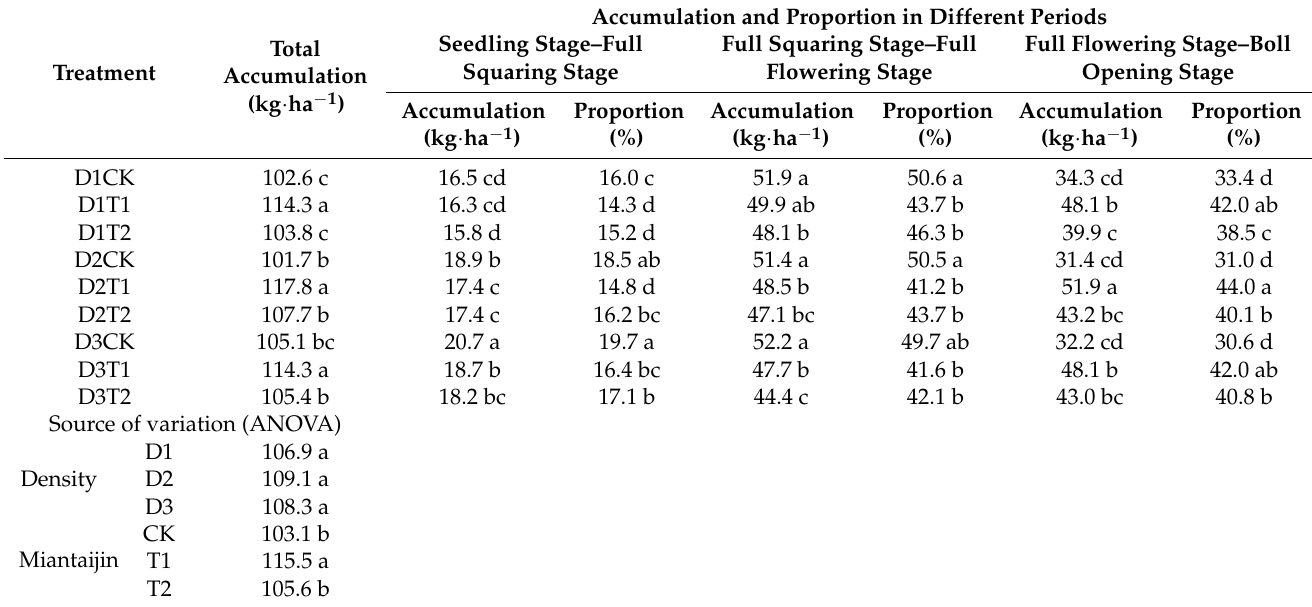
Table 3. Effects of density and Miantaijin on N accumulation (2018).